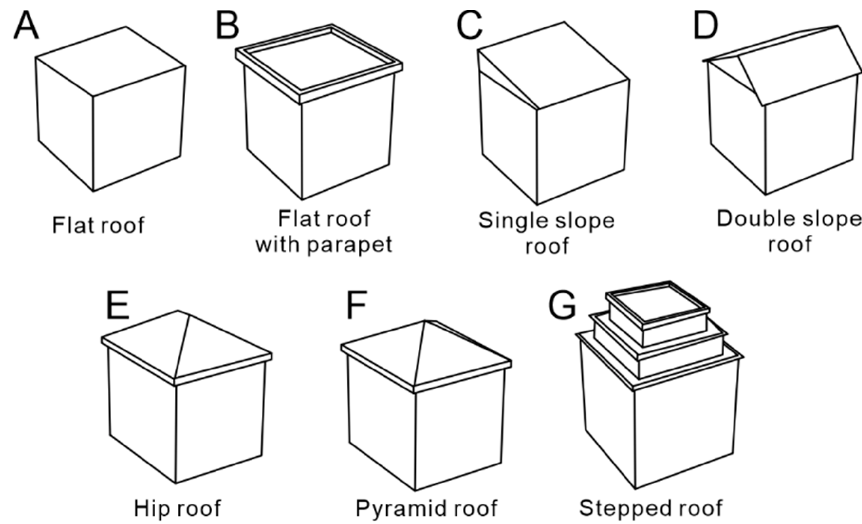
Figure 7. Seven types of roofs (( A ) Flat roof, ( B ) Flat roof with parapet, ( C ) Single slope roof, ( D ) Double slope roof, ( E ) Hip roof, ( F ) Pyramid roof, and ( G ) Stepped roof).